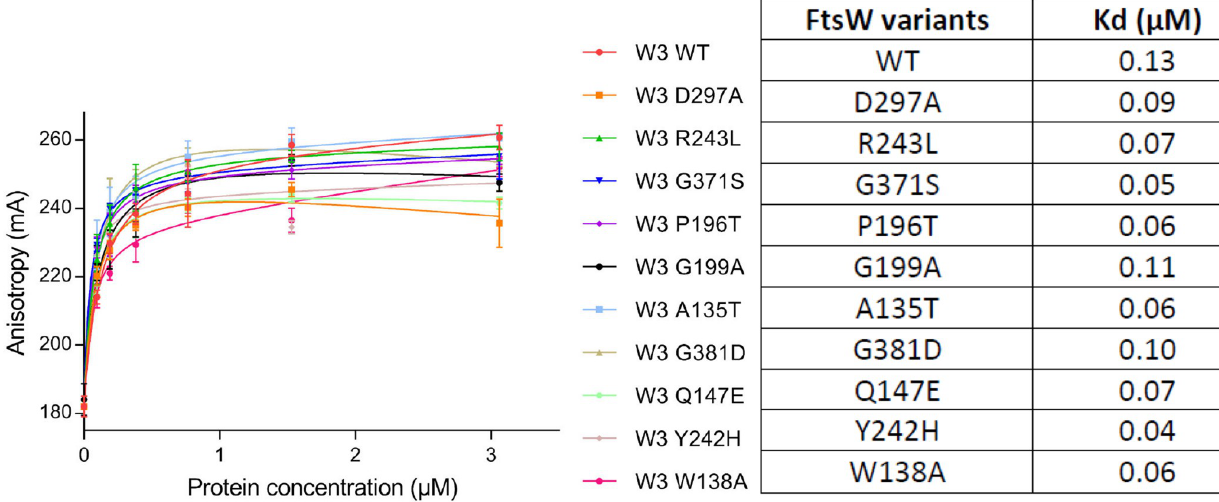
Fig 10. Direct binding of the FtsW variants to NBD-lipid II assayed by a fluorescence anisotropy (FA) assay. The assay was performed as described in Materials and Methods. FA (in mA units) is plotted as a function of FtsW-FtsI/PBP3 complex concentrations. FtsW-FtsI/PBP3 is indicated by “W 3”. The error bars represent the FA values as mean ± s.d. of triplicate experiments. The disassociation constant Kd ( μ M) of FtsW-FtsI/PBP3 variants for NBD-lipid II was determined with Graphpad Prism 6.0 and is indicated to the right.